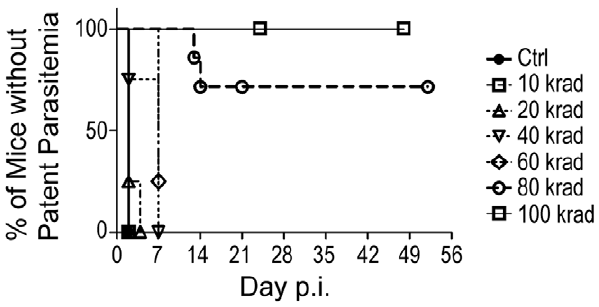
Figure 1. Determination of the radiation dose necessary to attenuate blood-stage Pb-A parasites. Virulent Pb-A parasitized RBC (pRBC) were exposed to increasing doses of gamma irradiation (10, 20, 40, 60, 80, 100 kilorads). 10 7 irradiated pRBC or non-irradiated control pRBC (Ctrl) were injected intravenously (iv) into groups of naı¨ve CD1 mice and parasitemia was monitored by blood smear. The graph shows the percentage of mice without patent parasitemia in each group over time beginning with day 2. Data are pooled from 3 experiments. Groups of mice infected with control pRBC or with pRBC exposed to 10, 20, 40, or 60 krad irradiation all developed patent parasitemia by day 7 (n=4 mice each group). Accordingly, the curves describing these groups approach 0% by day 7. 70% (10/14) of mice infected with 80 krad irradiated pRBC remained free from patent blood- stage disease by day 14 (open circles, dashed line). 100% (10/10) of the mice injected with 100 krad irradiated pRBC remained free from blood stage infection under the period of observation (open squares, solid line). 100 krad irradiation was chosen as the attenuating dose in subsequent experiments. blood-stage Pb-A parasites, and so the 100 kilorad dose was chosen to attenuate parasite growth in subsequent experiments.